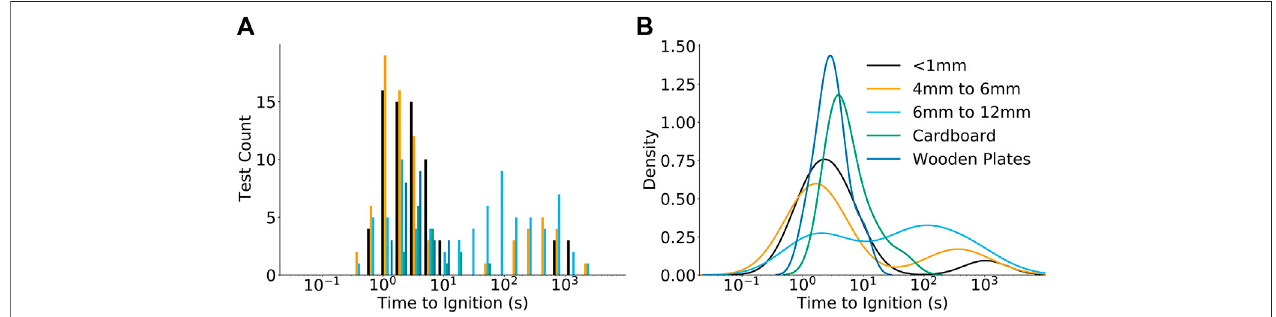
FIGURE5| Ignitioncount (A) andprobabilitydensity (B) oftimetoignitionforthefuelbedmaterialstested.Thedashedanddottedboxescorrespondingtothetwo zones of ignition from Figure 4 .